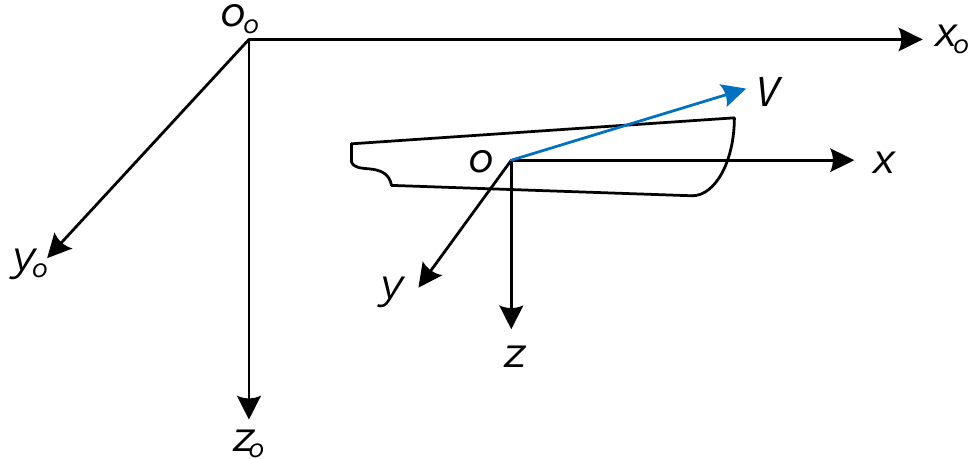
Figure 4. Ship-maneuverability motion coordinate system.